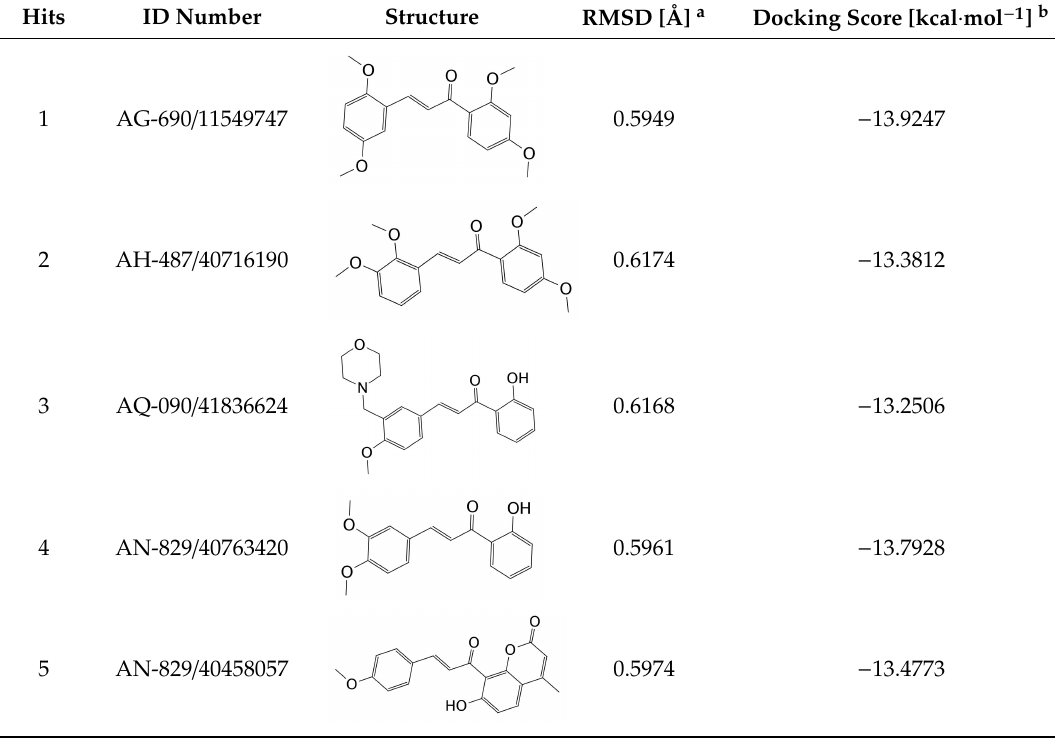
Figure 3. Pharmacophore mapping of five hits on model. Pharmacophore features are color-coded: Red, one hydrogen-bond acceptor feature (F1: Acc); yellow, aromatic features (F2 and F3: Aro); blue, one hydrophobic feature (F4: Hyd). The hits are shown in stick form; protein backbone and active site residues (green) are shown in line form; red balls mean water molecules; a gray pocket represents the shape of the binding site in tubulin. Table 3. Hit compounds selected from Specs database. Table 3. Hit compounds selected from Specs database.